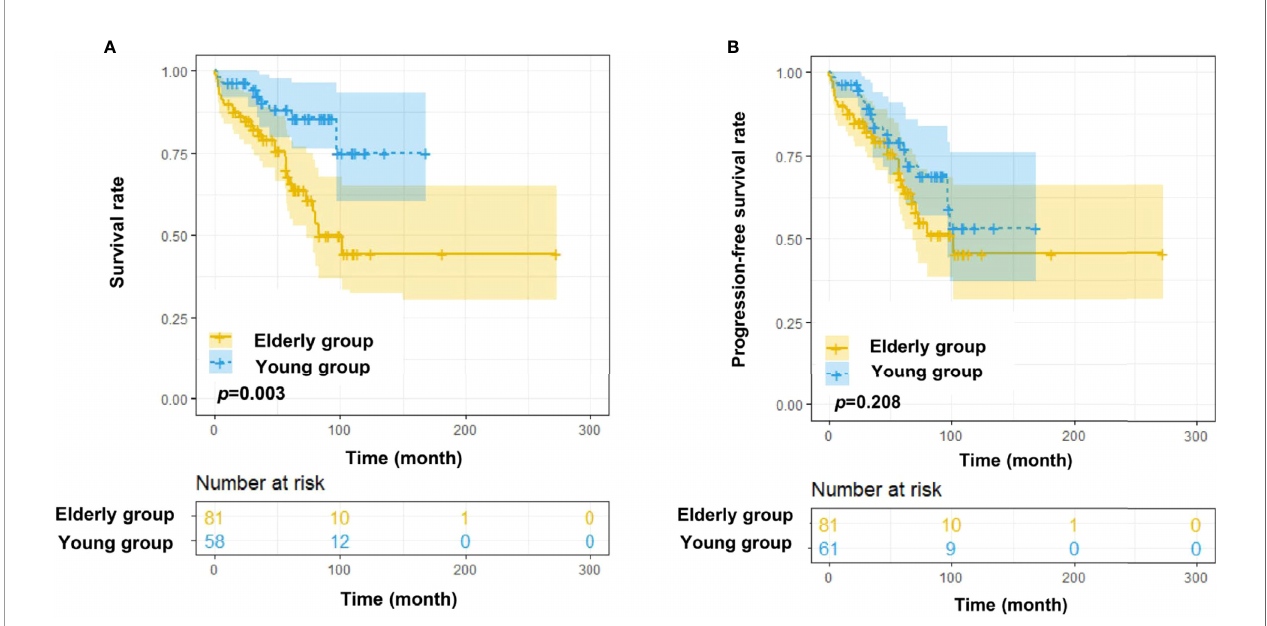
FIGURE 3 | Survival analysis of Chinese CLL patients. (A) OS differences among young (<60 years old) and elderly ( ≥ 60 years old) Chinese CLL patients from the SPHCLL database. (B) Progression free survival (PFS) differences among young and elderly Chinese CLL patients from the SPHCLL